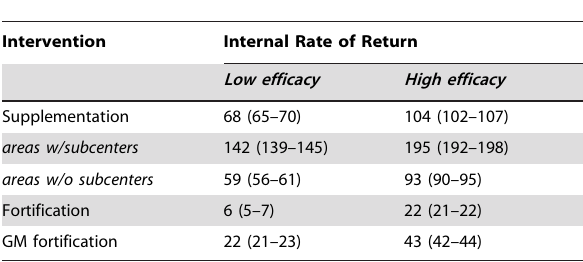
Table 6. Internal rates of return for each